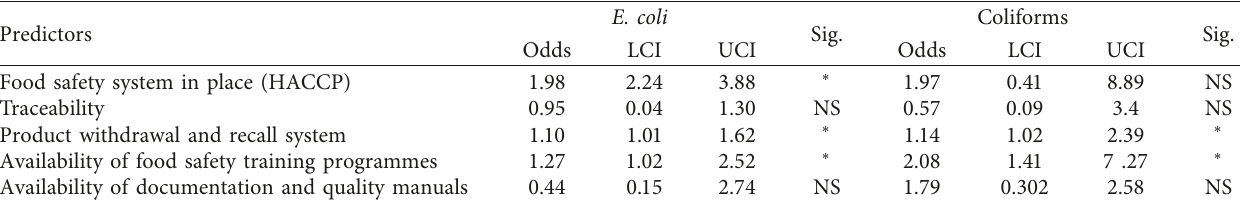
Table 5: Odds ratio estimate and lower (LCI) and upper confidence interval (UCI) of cultured buttermilk from milk processors with different food safety systems (absent vs. present) having E. coli or coliforms.